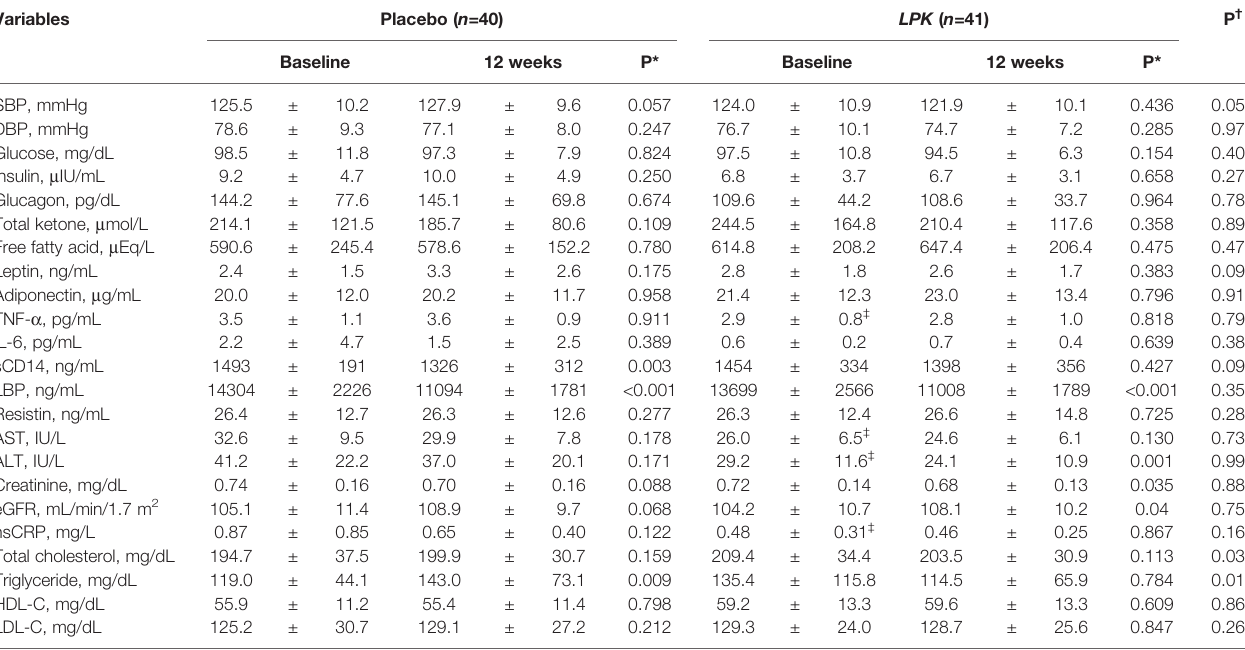
TABLE 3 | Changes in blood pressures and biomarkers in the LPK and placebo group after 12 weeks.